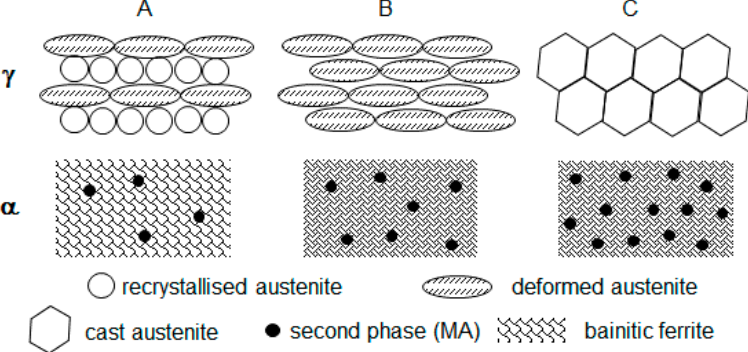
Figure 5. Schematic presentation of microstructure development in the MoNbTi ‐ steel with processing route ( A – C ); γ : austenite temperature range, α : ferrite temperature range.